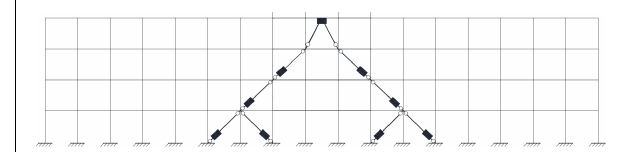
FIGURE 13 | Dissipative braces